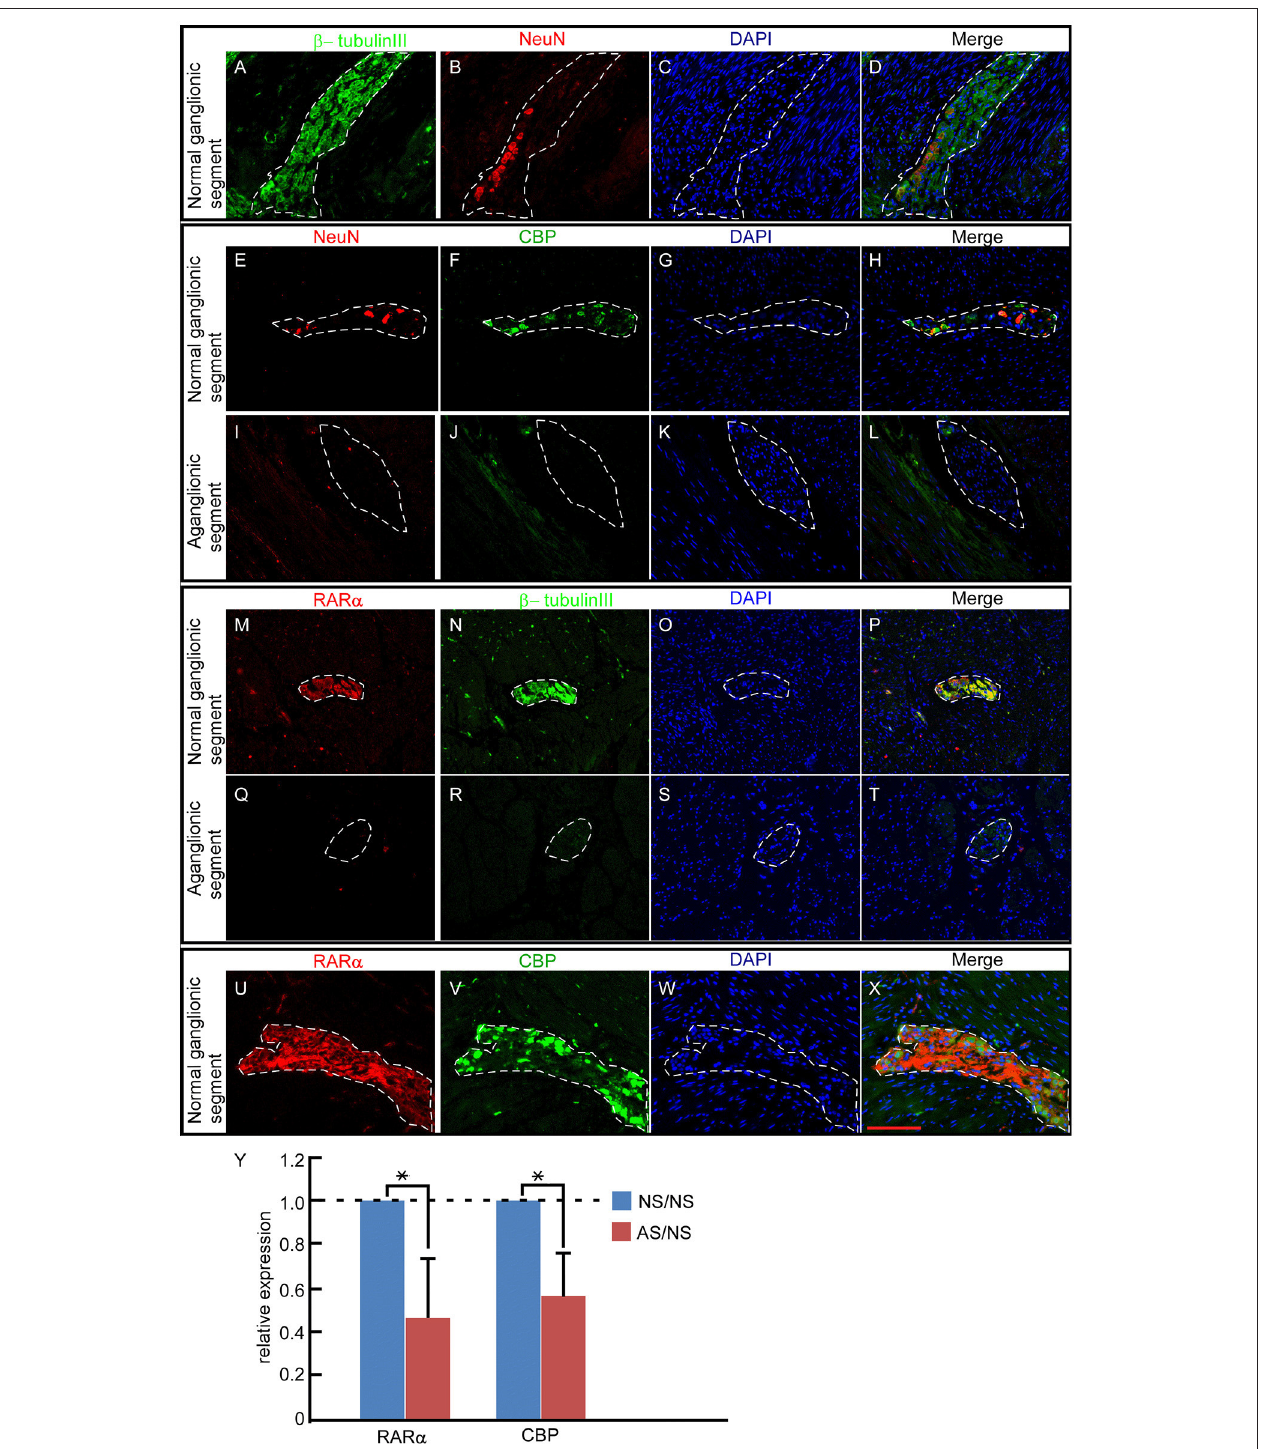
FIGURE 1 | RAR α and CBP expression patterns in the enteric nervous system of HSCR patients. (A–D) In normal ganglionic segments, β -tubulin III (green)-labeled nerve fibers (A) and NeuN protein (red) indicate ganglion cells (B) . DAPI-stained cell nuclei (C) β -tubulin III and NeuN displayed partially overlapping expression patterns in the neural plexus, as shown in the merged panel (D) . (E–H) In normal ganglionic segments, CBP protein (green) (F) -labeled ganglion cells are detected by